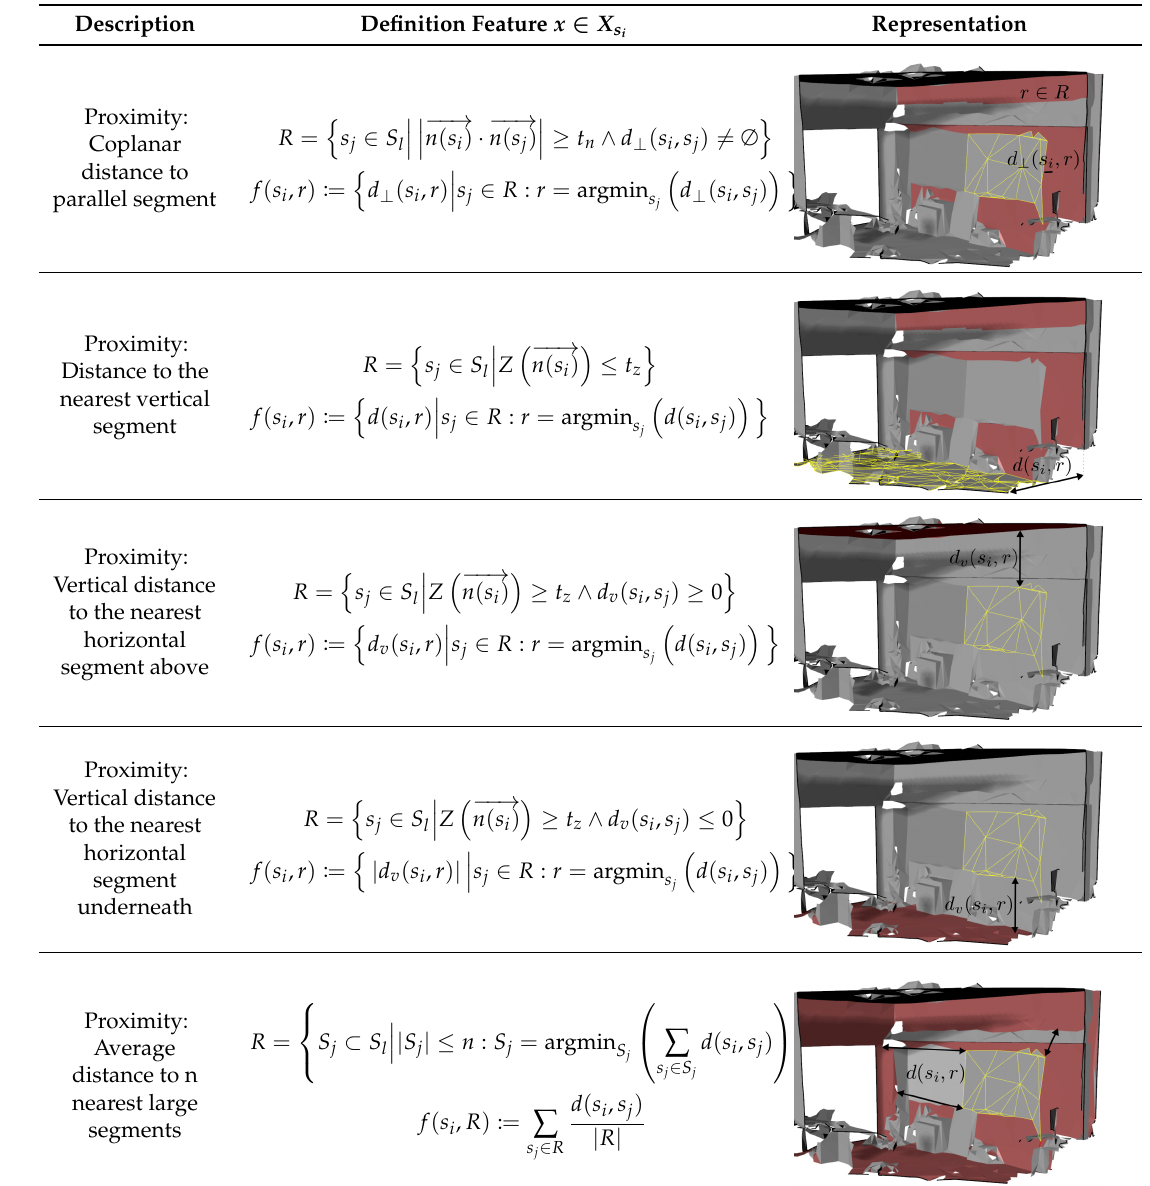
Table 3. The proximity features extracted from each s i ∈ S with respect to nearby reference segments R